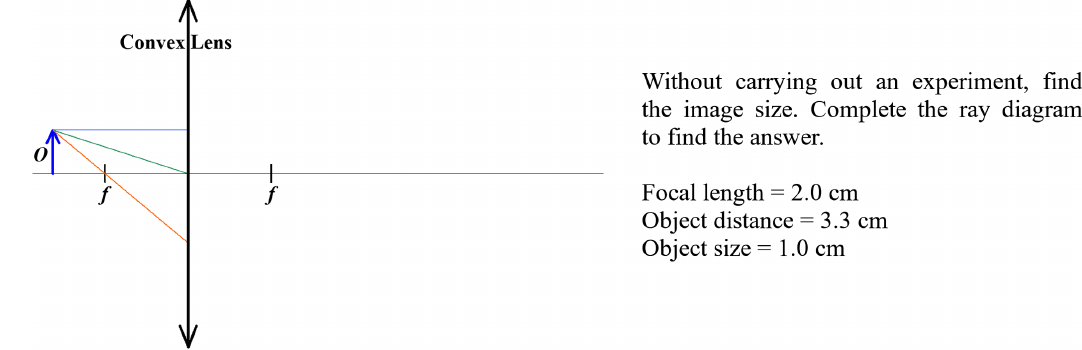
FIG. 4. Conventional task of the CG for practicing the construction of ray diagrams for an image-forming experiment with a convex